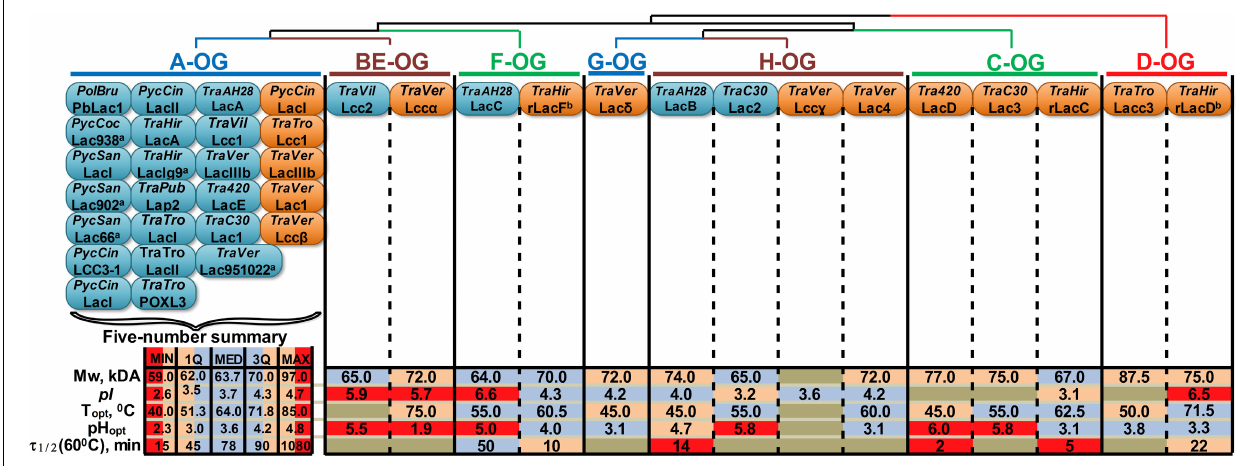
FIGURE 4 | Orthology-based classification of laccase isozymes with the summary of their physicochemical properties. The phylogenetic relationships between different OG are represented by the dendrogram. The blue and orange oval shapes represent different laccases of native or recombinant isozymes (respectively); the proteins nomenclature provided in accordance with the source (see Supplementary Table S2 ), unless otherwise is indicated; a named according to the strain number; b data obtained in this study. TraPub, TraTro, Tra420, TraC30 designate Trametes pubescens , Trametes trogii , Trametes sp. AH28-2 and Trametes sp. C30, respectively. For other abbreviations, refer to Figure 1 . For group A , a five-number summary is provided, with MIN, MAX, MED, 1Q and 3Q being the minimum, maximum, median, first and third quartiles, respectively. The data regarding laccases from groups BE - H are color-coded according to their locations in the corresponding five-number summary